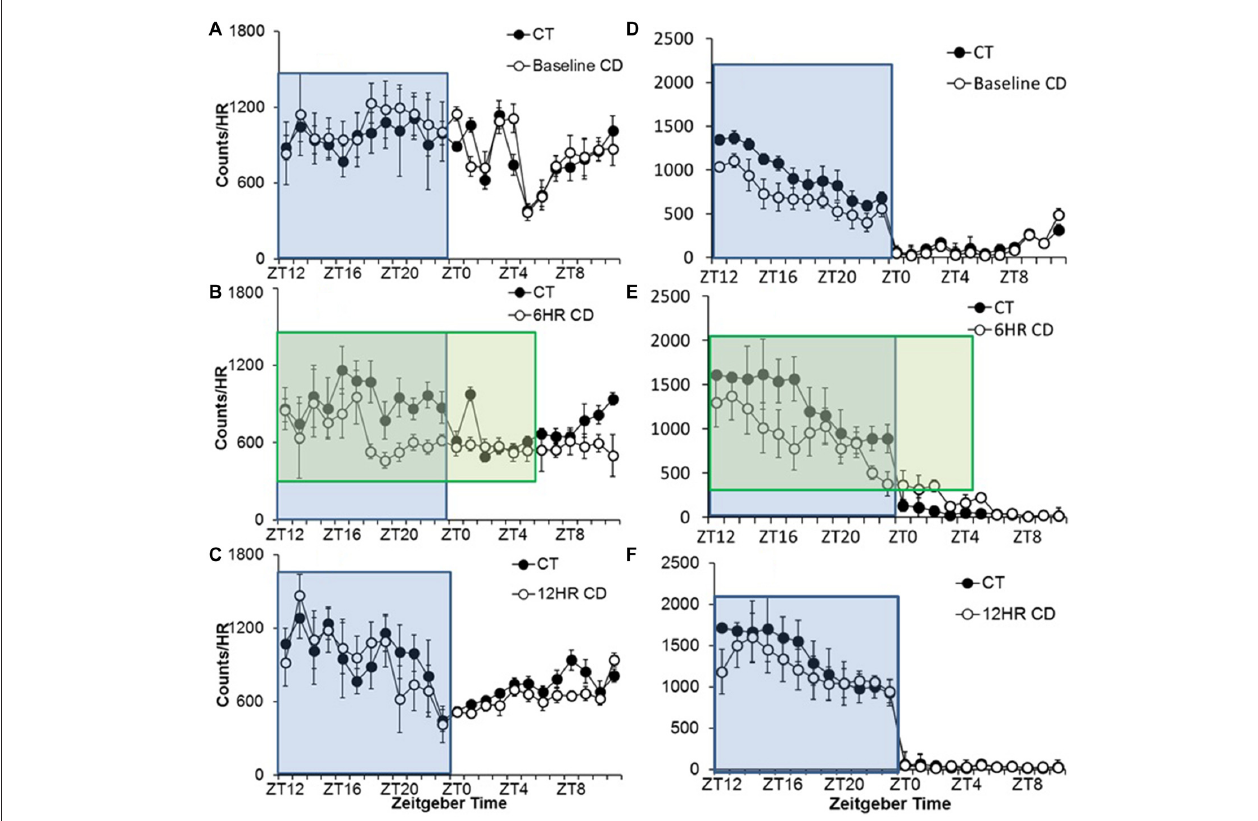
FIGURE 4 | Overall activity counts by hour in adolescent C57BL/6J mice during baseline alcohol access and 6HR environmental CD. There were no differences in patterns of baseline alcohol intake (A) , but mice in CD drank significantly less during the second half of the lights-off period in the 6HR photoperiod (B) with no changes in the 12HR photoperiod (C) . There were no significant differences in baseline wheel-running (D) , and mice in CD showed decreased activity in the dark, especially in the 6HR photoperiod (active phase; E,F ; blue boxes indicate normal 12HR dark; green boxes indicate 18HR dark phase for mice in CD; data indicate the mean ± SEM for n =